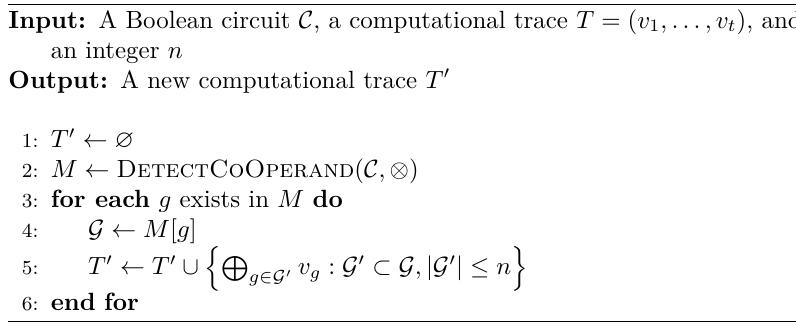
Algorithm 7 TraceProcessingSubset ( T, C , n